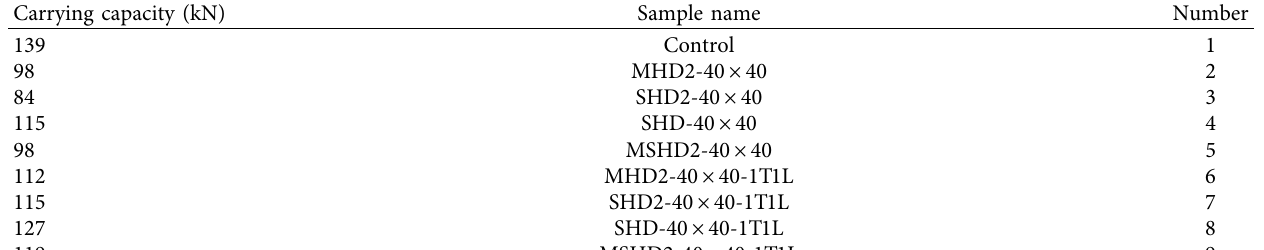
Table 5: Bearing capacity of the models modeled in ABAQUS program.